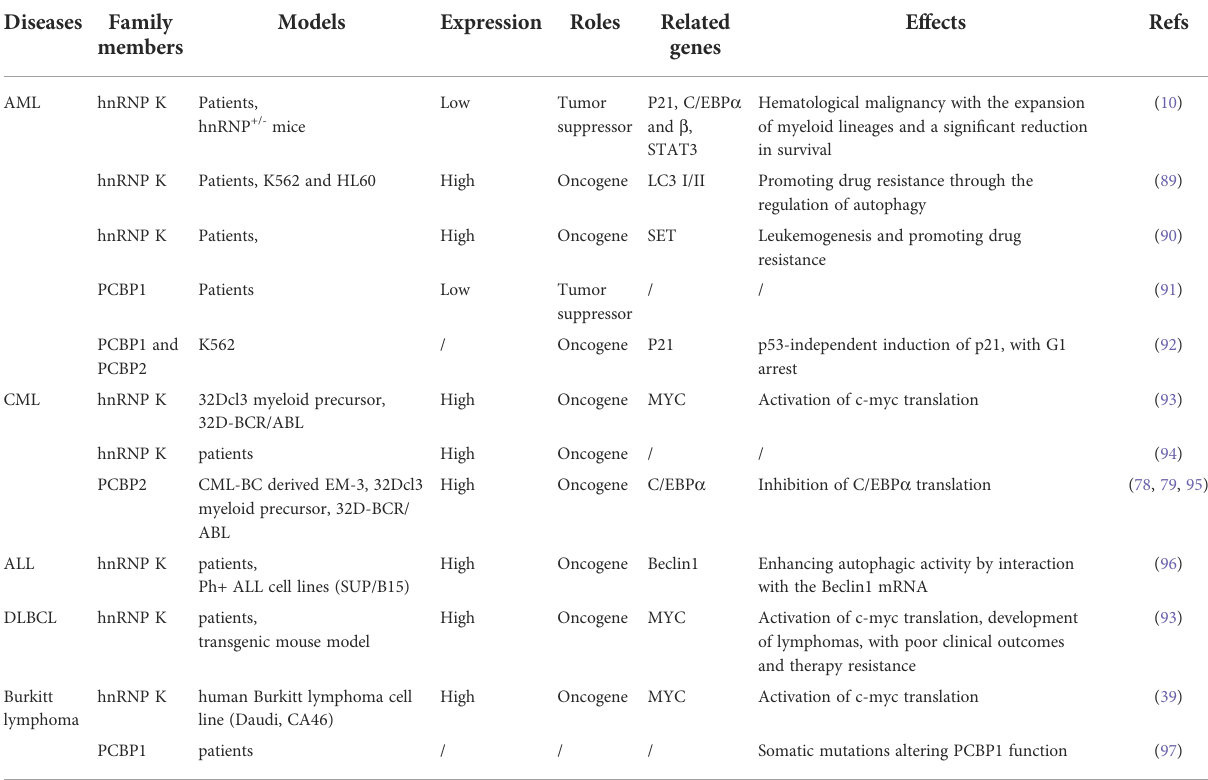
TABLE 2 The roles and underlying mechanisms of hnRNP K, PCBP1, and PCBP2 in hematopoietic disorders. Diseases Family